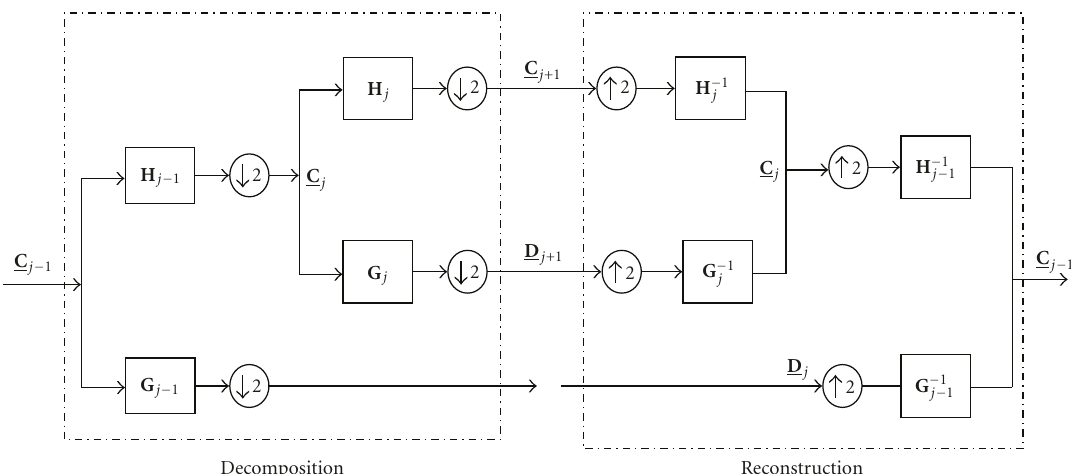
Figure 8: Multiresolution analysis using piecewise polynomial scaling and wavelet